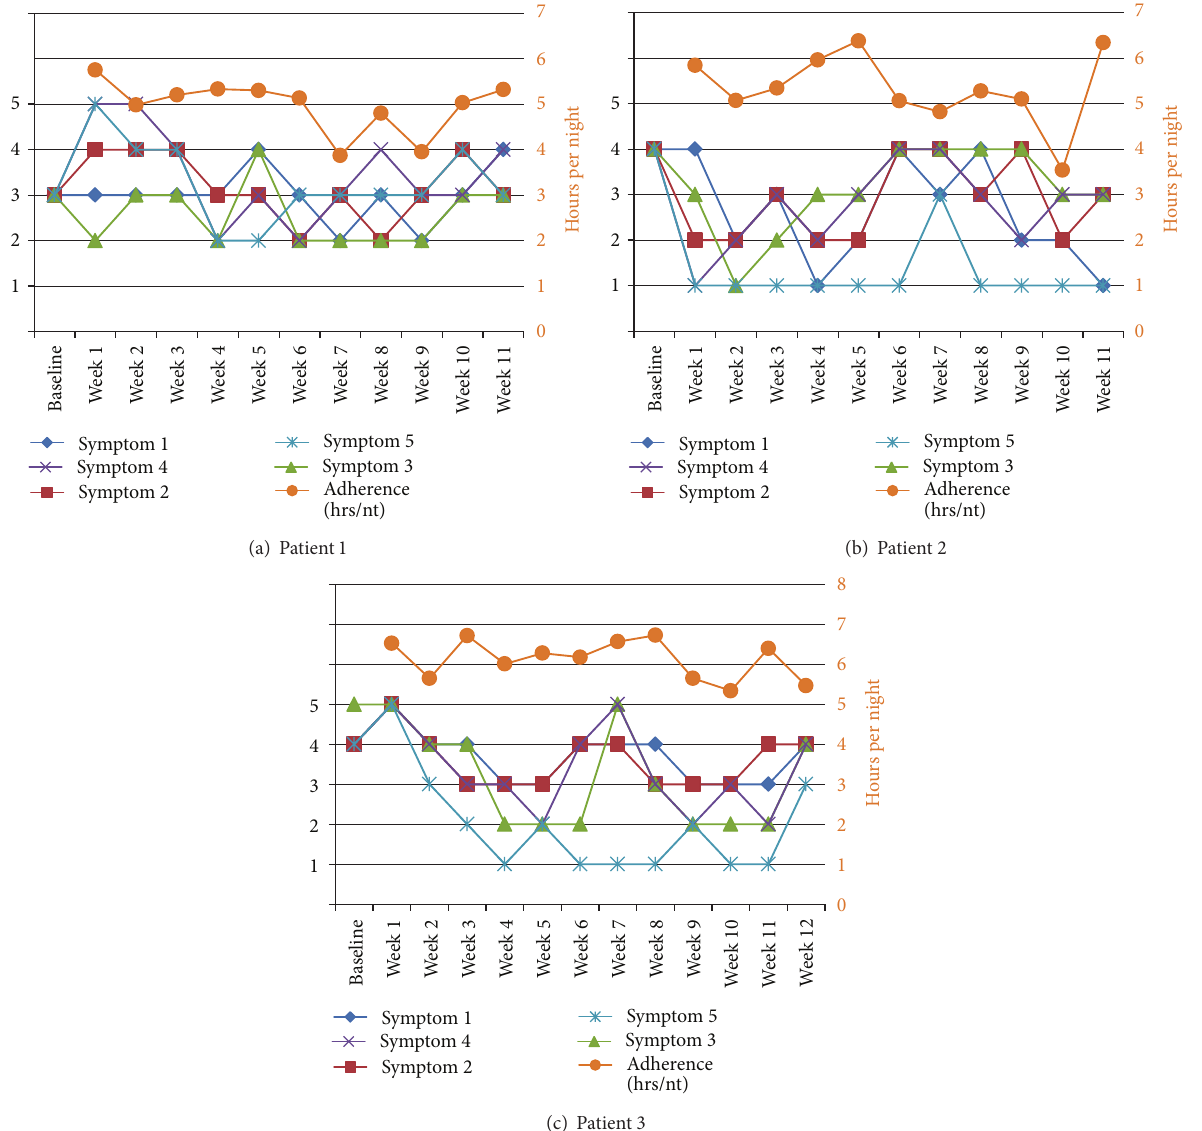
Figure 5: Tracking sleep apnea symptoms over time: example of three